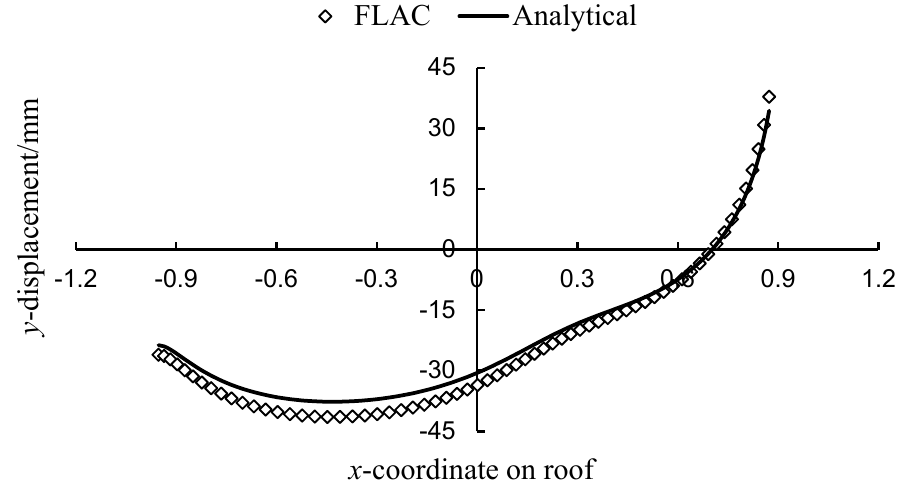
Figure 6. The y -displacement on roof for right-angle trapezoidal opening. Figures 7 and 8 show the horizontal displacement ( x -displacement for short) on the left side (also called “low side”) and right side (also called “high side”) for right-angle trapezoidal openings as shown in Figure 3a, respectively. In the same way, the positive value of x -displacement denotes that the horizontal displacement is along the Ox -axis, and the negative value indicates the opposite direction to the Ox -axis. It can be clearly obtained that the values of x -displacement on the left side are all positive numbers and these are almost negative numbers on the right side, which indicate that the left and right sides of opening are close to each other. The x -displacements on the left side around corner E are bigger than that around corner A and the x -displacements on the middle of the right side are bigger than that around corner B and corner F . This indicates that more bolt supporting is needed around corner A on the low side and the middle of the high side for